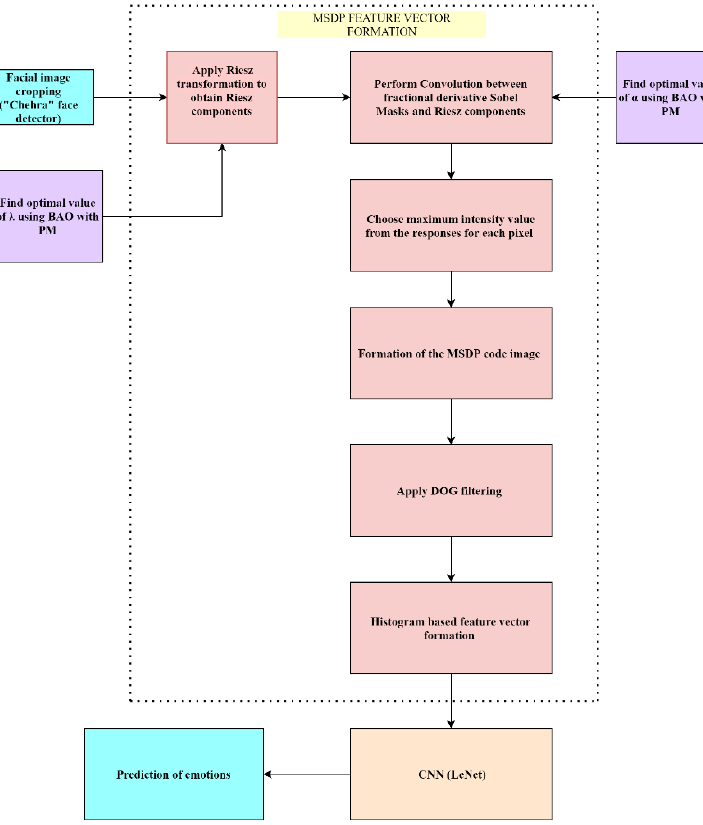
Figure 2. MSDP feature vector formation and classification.